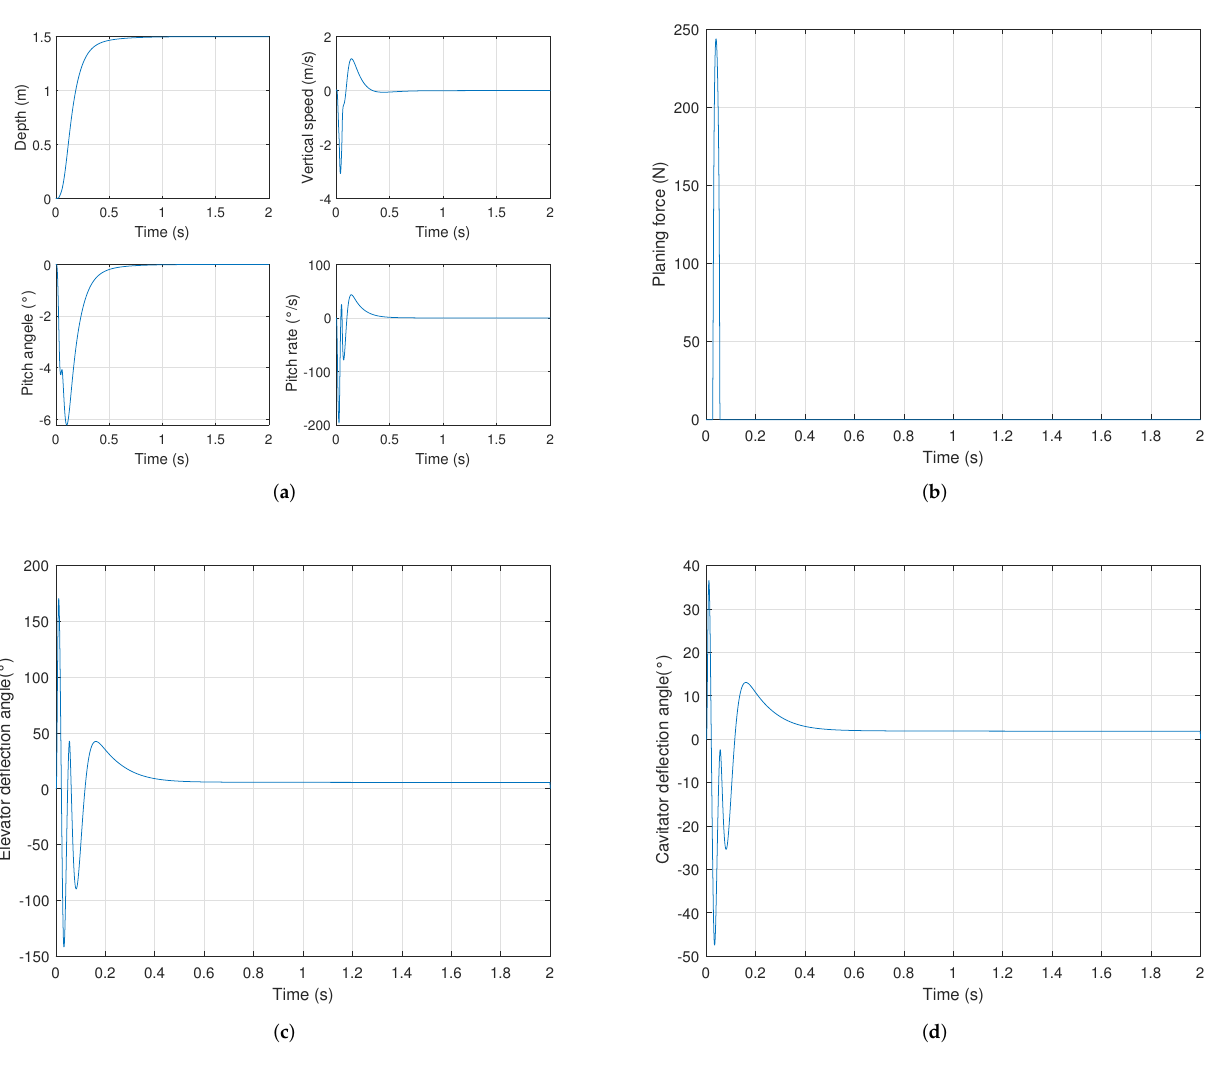
Figure 9. States, planing force and actuator deflections of the supercavitating vehicle under DACC without Tracking-Differentiator (TD): ( a ) Four states; ( b ) planing force; ( c ) Elevator deflection an- gle; ( d ) Cavitator deflection